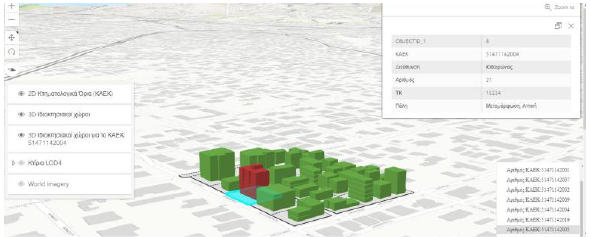
Figure 8. Results of using ‘Highlight tool’ at the entity of 2D parcels based on ‘KAEK’